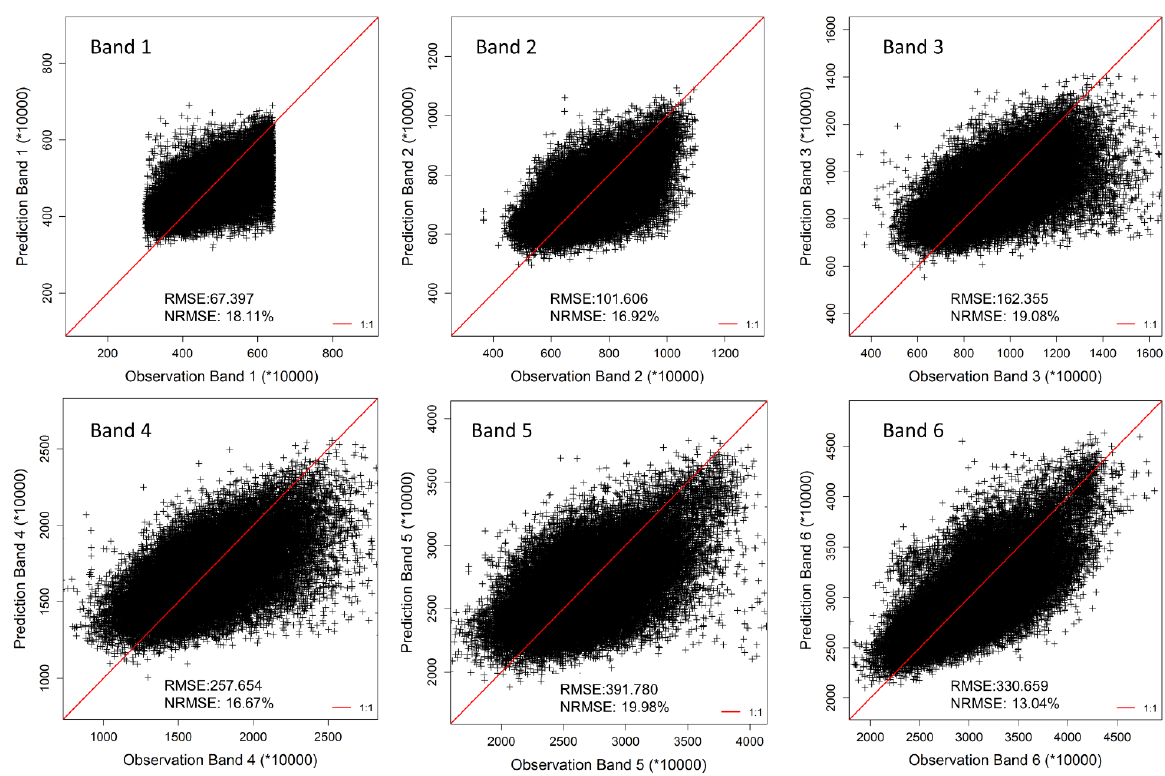
Figure 10. Observation and prediction plot of bands 1–6 based on two correlations of each location in entire study area.